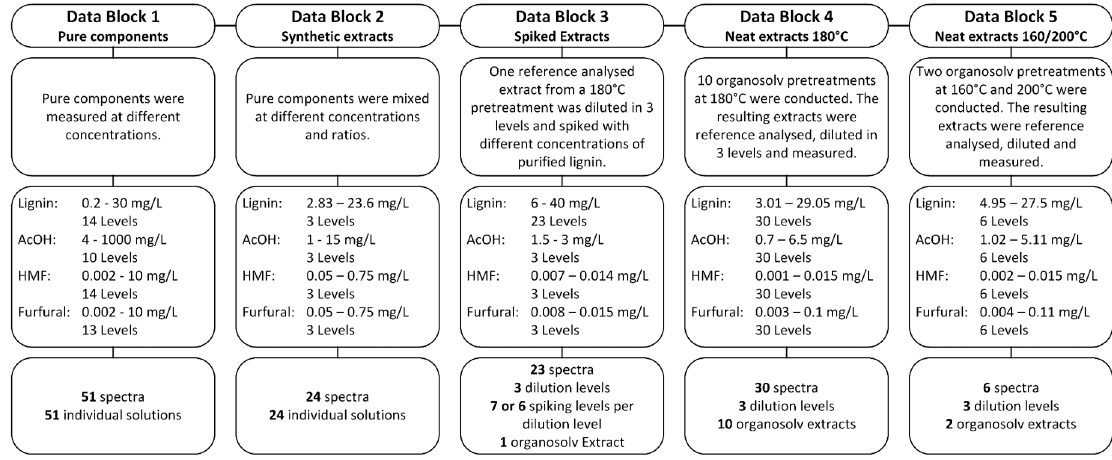
Figure 1. Details of the five data blocks used for the multivariate calibration.